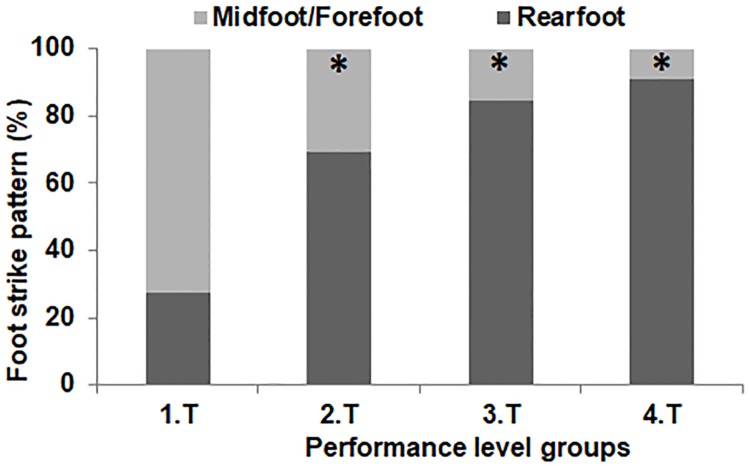
Foot strike pattern distribution (midfoot/forefoot and rearfoot) in each group of runners.G1, G2, G3, G4, groups of runners of different performance level (< 70, < 80, < 90 and < 105 min, respectively). *, significant differences with Group 1.